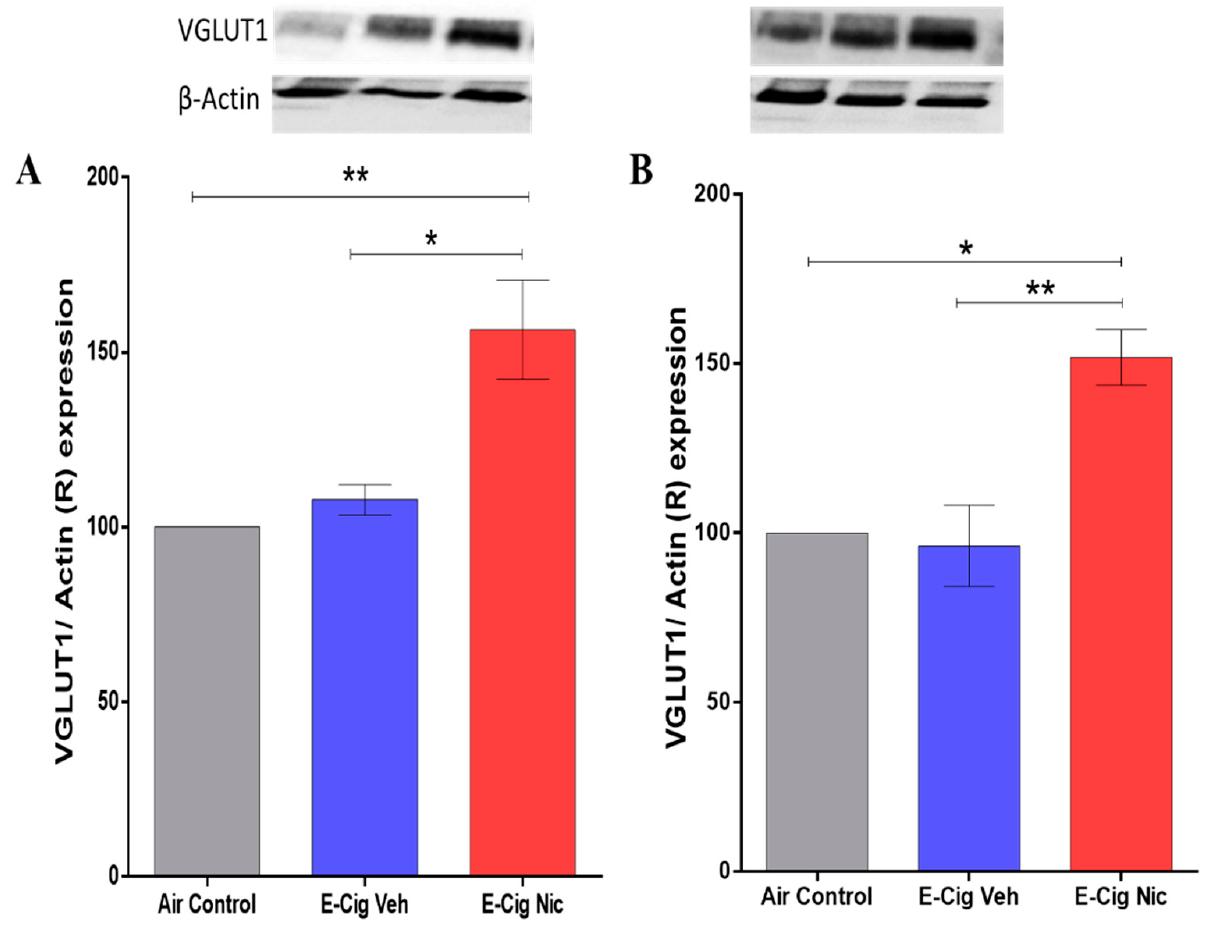
Figure 7. Relative (R) expression of VGLUT1 in the hippocampus following four-week inhalation of e-cigarette vapors containing nicotine. ( A ) Representative VGLUT1 expression blots in the hippocampus of males of all three groups (upper panel) and corresponding quantitative statistical analysis (lower panel). ( B ) Representative VGLUT1 expression blots in the hippocampus of females of all three groups (upper panel) and corresponding statistical analysis (lower panel). One-way analysis of variance (ANOVA) followed by a Tukey’s post hoc showed a significant increase in the the expression of VGLUT1 in the hippocampus in E-cig Nic group as compared to controls in both male and female mice. Data are presented as mean ± SEM (n = 3/group). E-cig, electronic cigarette; E-cig Veh, electronic cigarette with vehicle only; E-cig Nic, electronic cigarette with nicotine. (* p < 0.05, ** p < 0.01).